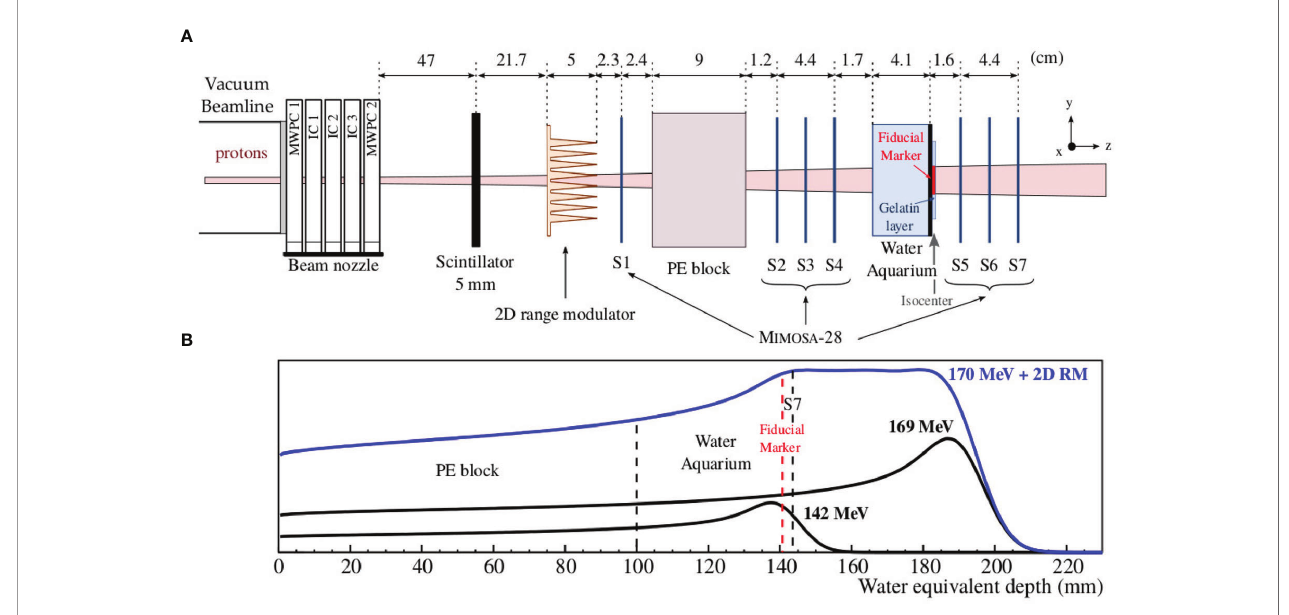
FIGURE 2 | (A) Experimental setup for fl uence perturbation of proton beams due to fi ducial markers, measured with 7 M IMOSA -28 pixel sensors. (B) The depth – dose pro fi les in water equivalent are shown for 142 and 169MeV protons, as well as for the 170-MeV proton beams modulated by a 2D RM. The depth – dose pro fi les were laterally integrated and obtained with the Monte Carlo code FLUKA (23-25). In this panel, the PE block, the water aquarium, and the positions of the fi ducial marker and of the last sensor S7 are also